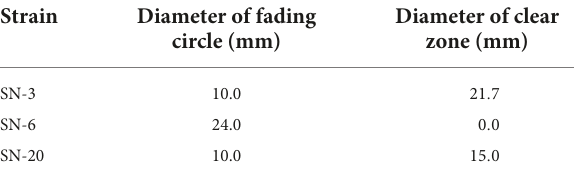
TABLE 2 Amylase/protease activity of strains.